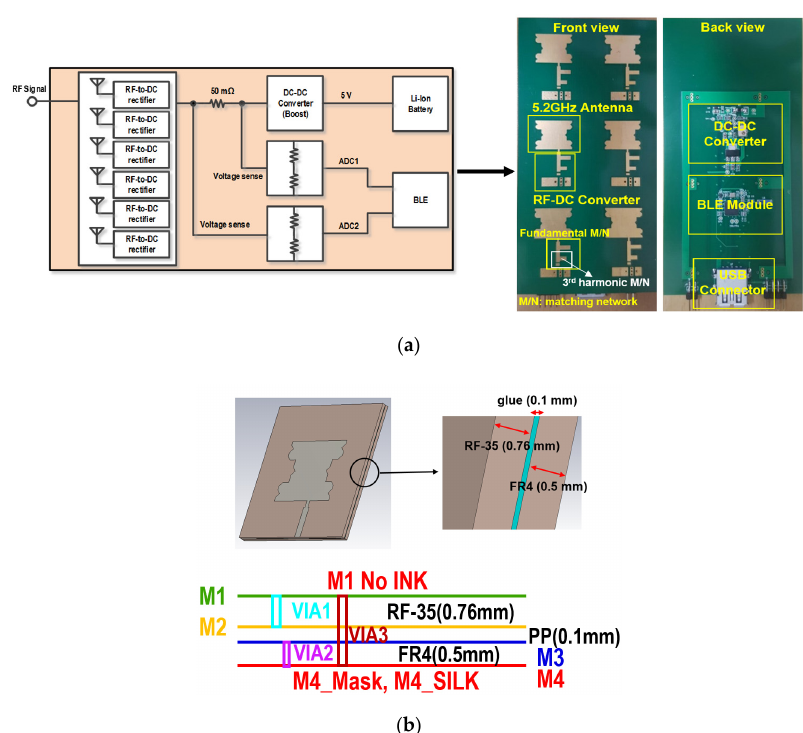
Figure 9. ( a ) Module of the fabricated RF RH, front (6-parallel rectenna) and back (Rx receiver) sides and ( b ) Information of the PCB layer (4 layers). Reprint with permission [4775431338148]; 2020, IEEE. Sensors 2019 , 19 , x FOR PEER REVIEW